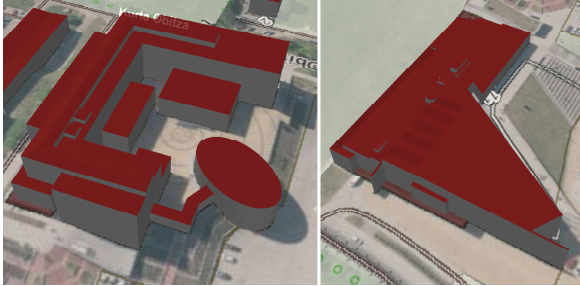
Figure 1 . 3D building models (object 1 – left; object 2 – right) visualized in the Polish National Geoportal.